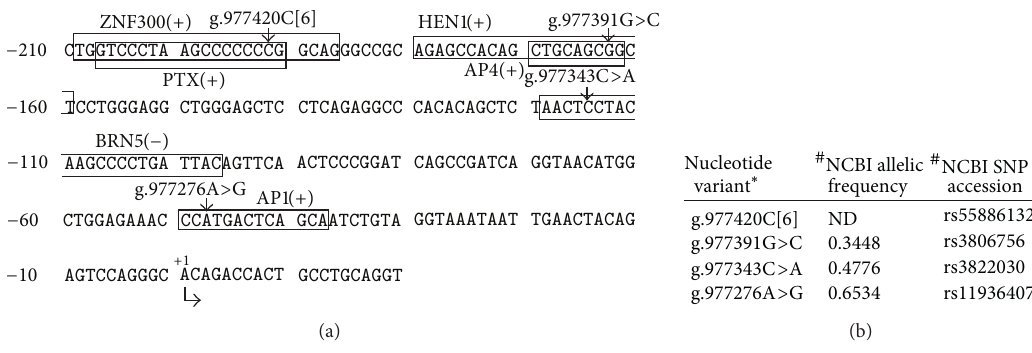
Figure 2: Sequence variants identified inthisstudy and theirlocation within putativetranscription factor binding sitesinthehuman SLC26A1 5 󸀠 -flanking region. (a) Nucleotide sequence of the SLC26A1 5 󸀠 -flanking region (NCBI accession number NT 037622.5) from − 210 to +20 is shown. Position +1 denotes the putative transcription initiation site (NCBI accession number AK292747). Putative transcription factor binding motifs are boxed, and their position on the plus (+) or minus ( − ) strands is indicated: ZNF300: KRAB-containing zinc finger protein 300; PTX1: pituitary homeobox 1; HEN1: helix-loop-helix transcription factor; AP4: activator protein 4; BRN5: BM-5 POU domain factor; AP1: activator protein 1. (b) Allelic frequencies and accession numbers of nucleotide variants in the NCBI database: # accessed 7 November 2012. ∗ Nucleotide numbering based on NCBI reference sequence NT